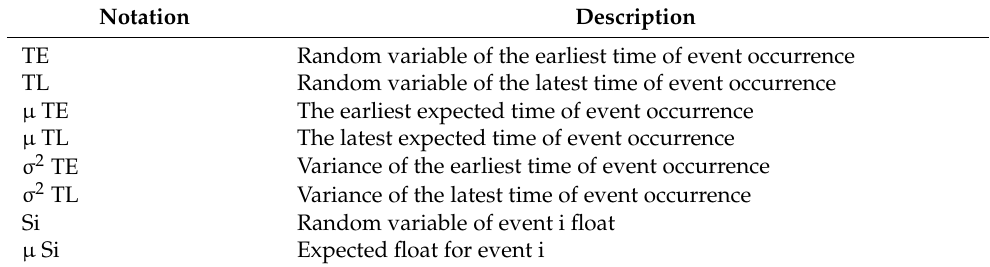
Figure 5. PERT networks displayed by AOA system. Table 1. PERT networks